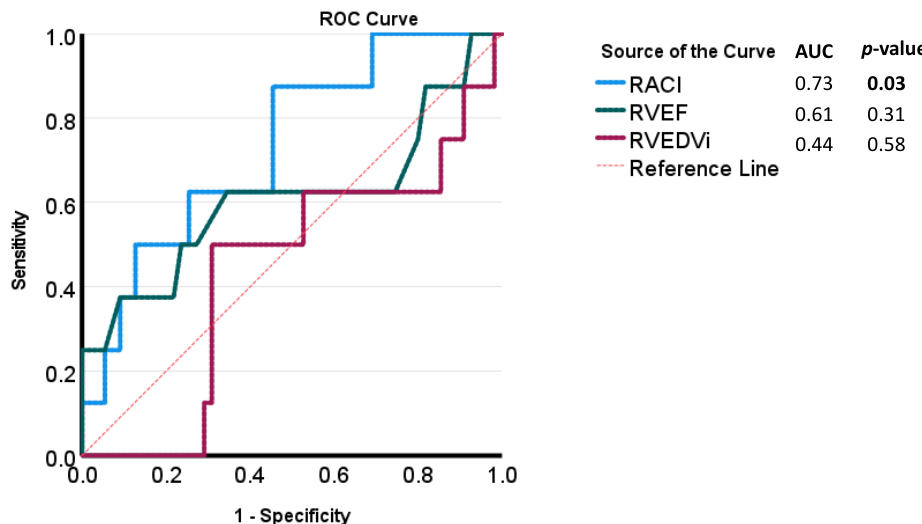
Figure 6. Receiver-operating characteristic (ROC) curves for CMR parameters for the evaluation of high-risk Importance Factor Scores (>2).